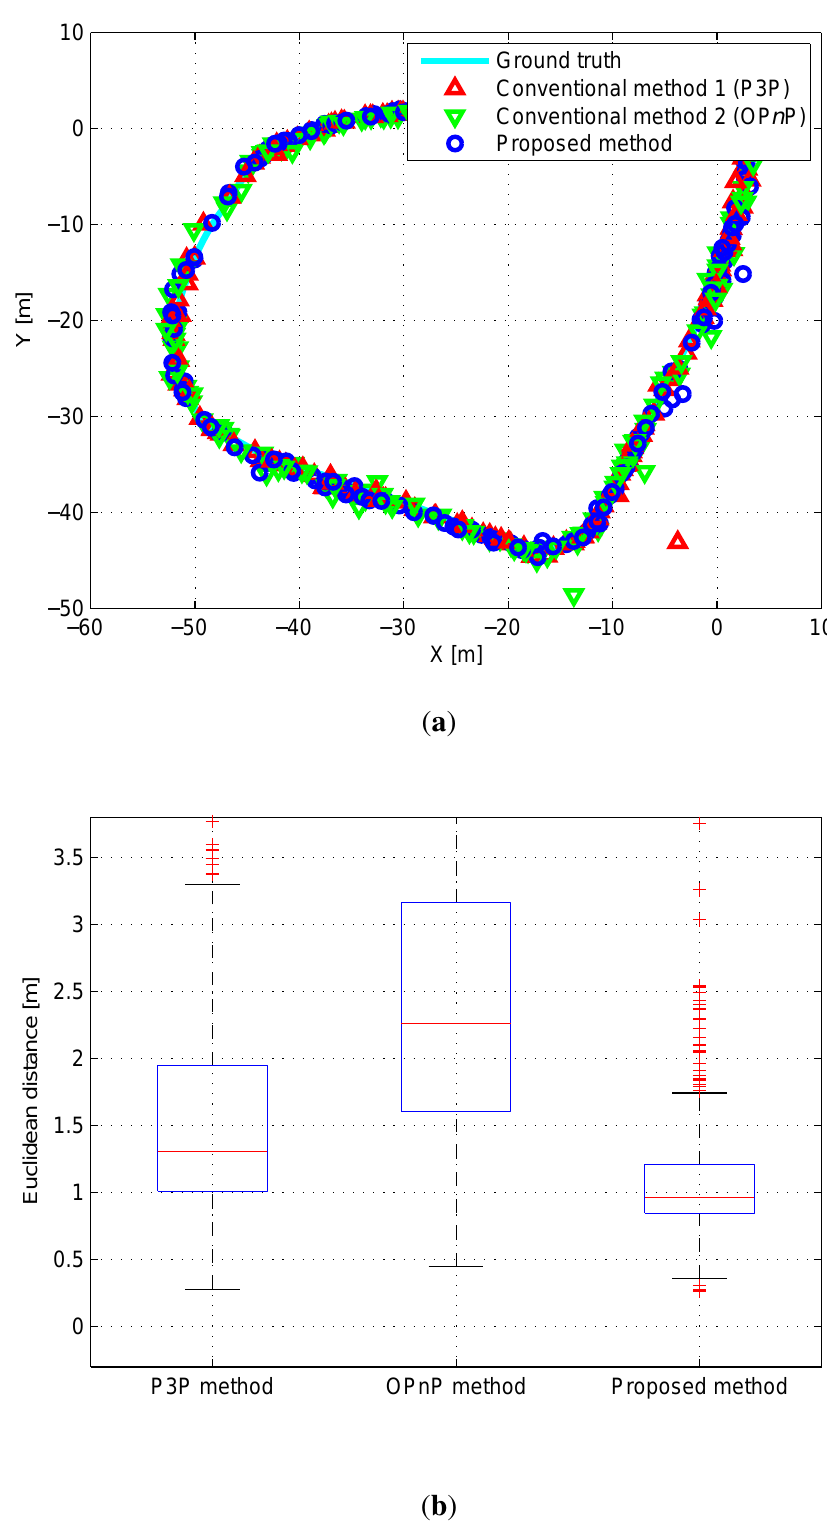
Figure 9. ( a ) Top view of the results of the indoor experiment. Red triangles, color1green triangles, and blue circles denote results of P n P, color1OP n P, and the proposed algorithm, respectively; ( b ) Euclidean distance errors relative to the ground truth